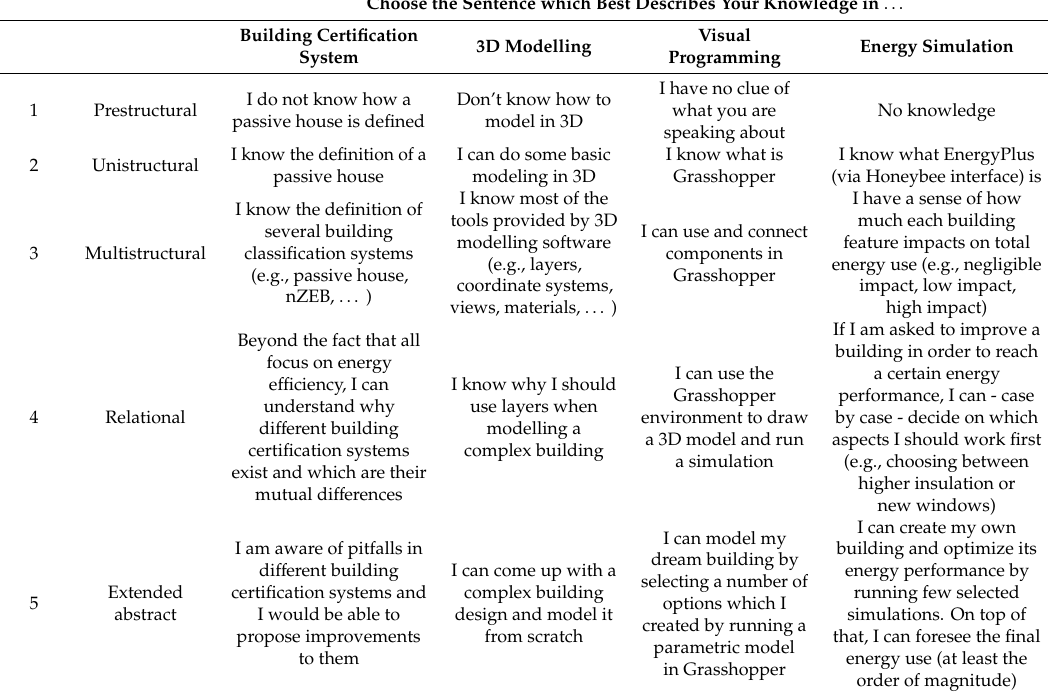
Table A2. Self-evaluation of learning outcomes based on SOLO taxonomy taxonomy (Biggs and Collis, 1982) [30] as submitted to C2019. Choose the Sentence which Best Describes Your Knowledge in